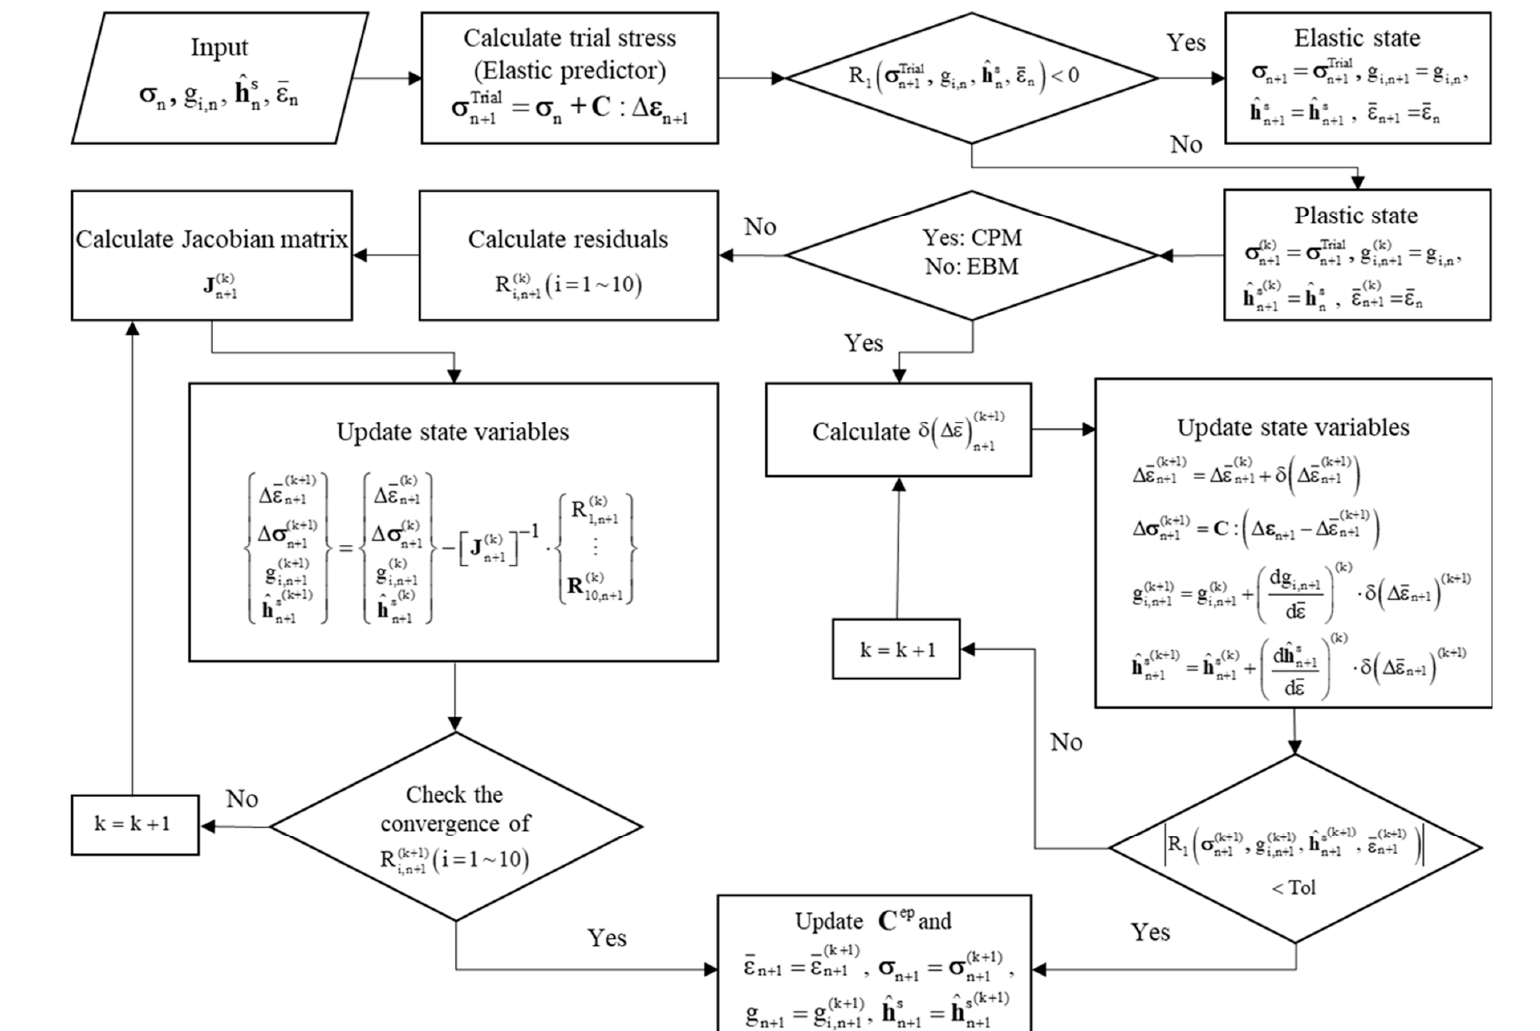
Figure 2. Flow chart for two stress update scheme; CPM and EBM.